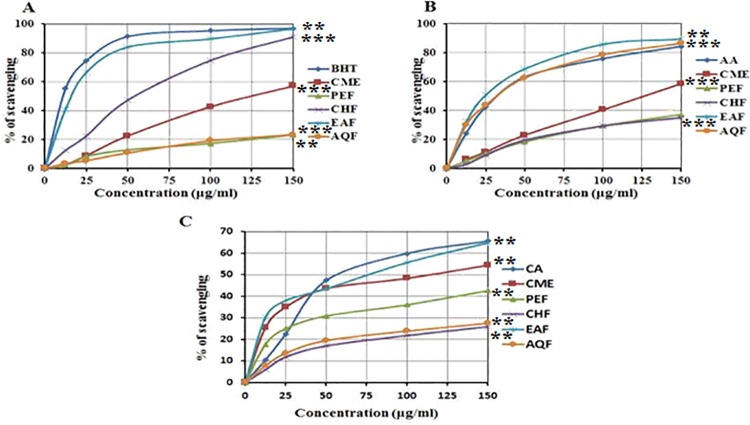
Determination of (A) DPPH radical scavenging activity, (B) OH radical scavenging activity, and (C) lipid peroxidation inhibition activity of CME and its various fractions (PEF, CHF, EAF and AQF). Data expressed as mean ± SD (n = 3) for all tested dosages. Significant differences of EAF values are compared to values of standard and various fractions and marked as asterisk (*p < 0.05, **p < 0.01, and ***p < 0.001).